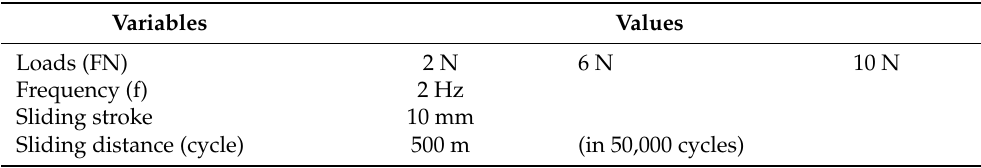
Table 3. Selected conditions for wear tests.